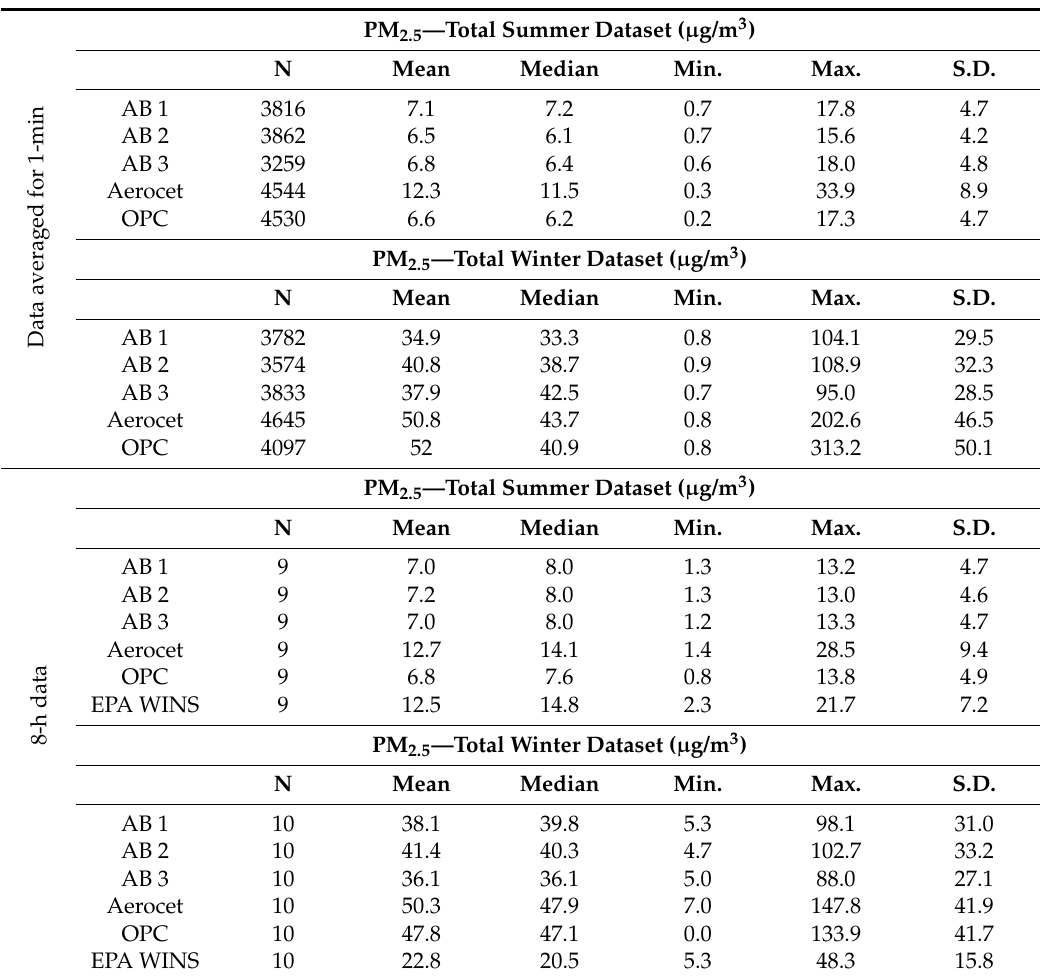
Table 2. PM 2.5 concentrations acquired with different monitoring devices. N: number of data point used for statistical analysis; Min: minimum; Max: maximum; S.D.: standard deviation.